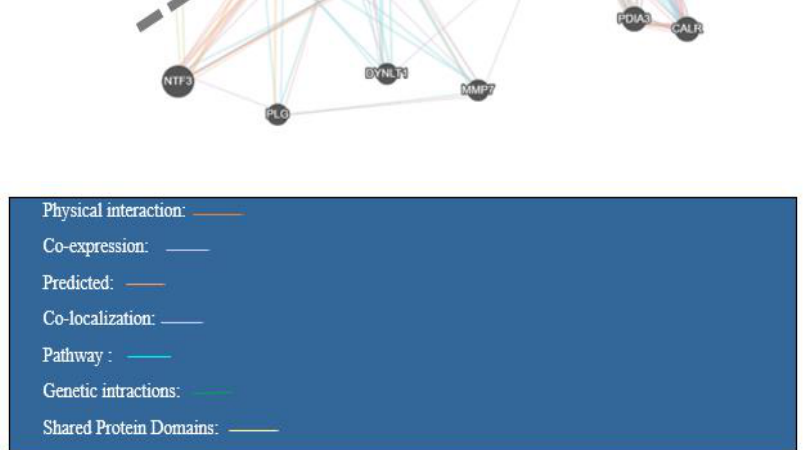
Figure 2. Gene interaction between overlap genes in obesity and mood disorder.